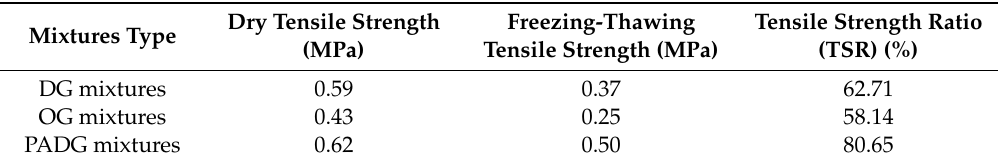
Table 4. Results of freeze-thaw tensile strength